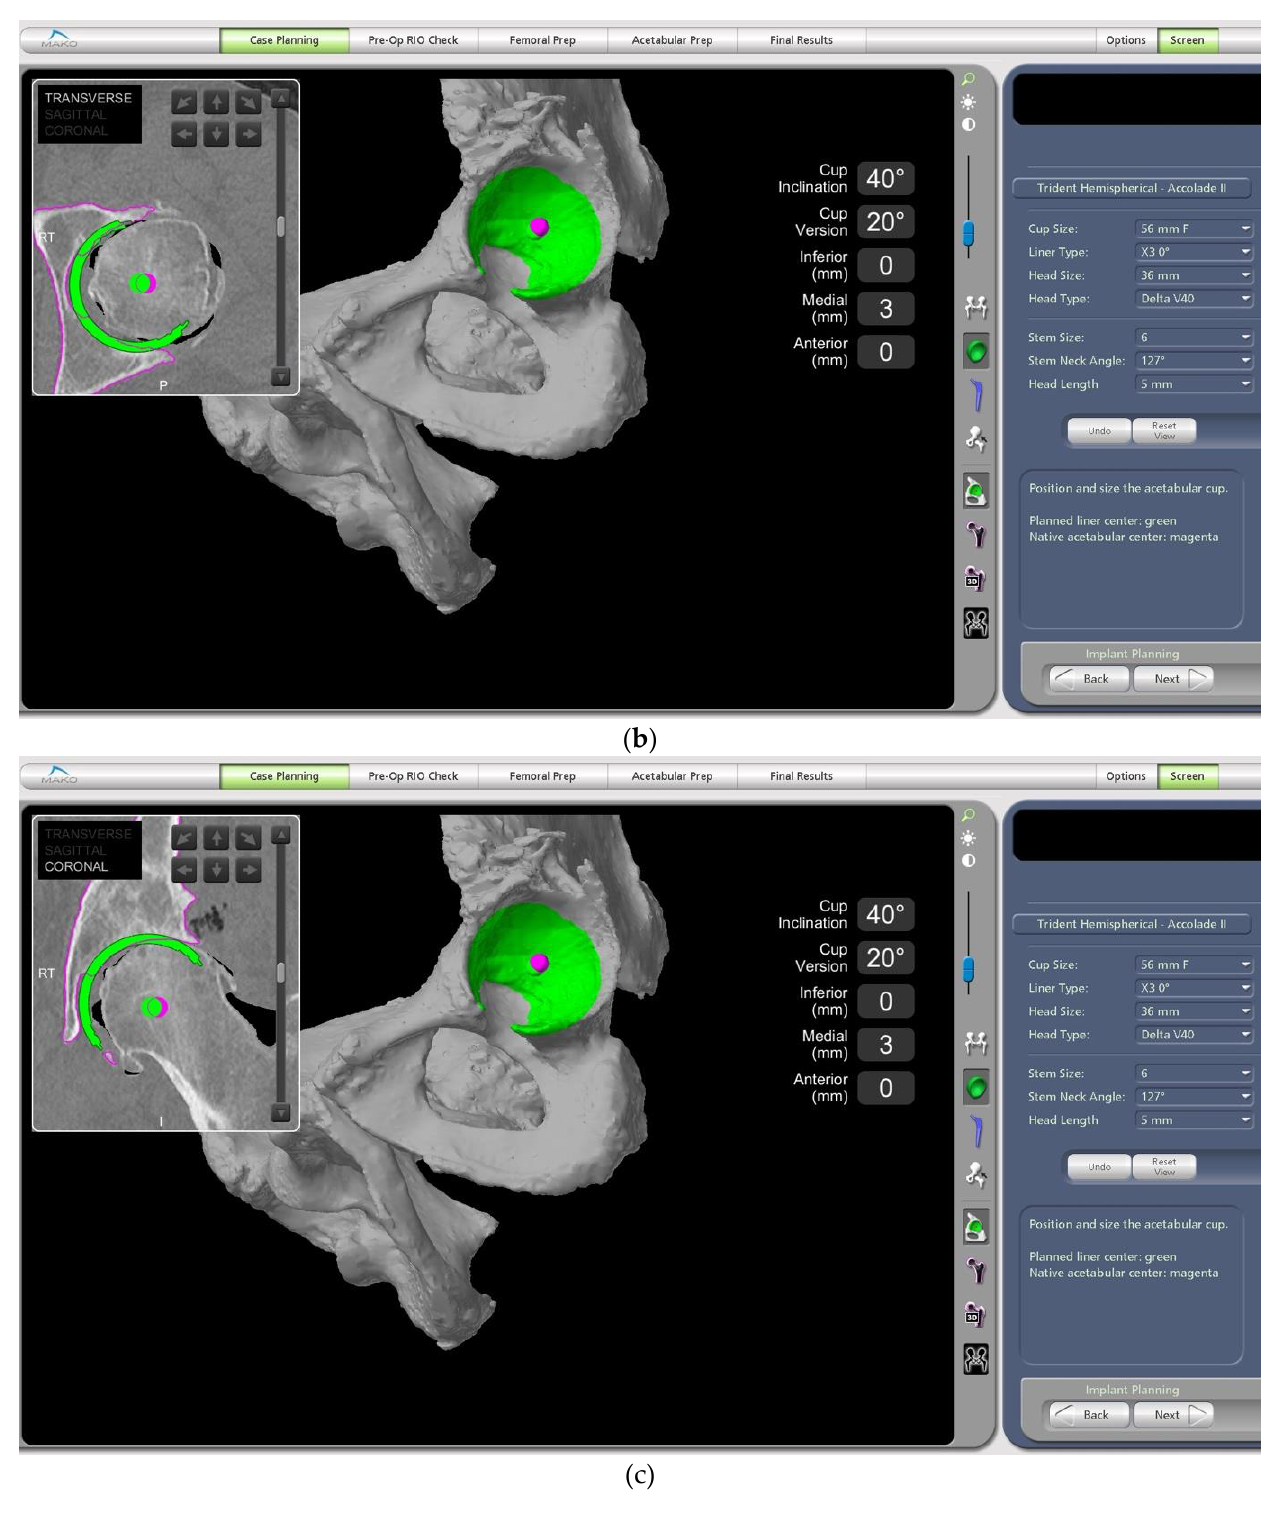
Figure 3. Evaluation of 3D bony coverage of the acetabular cup and careful planning in relation to restoring the native centre of rotation. ( a ) Sagittal. ( b ) Transverse. ( c ) Coronal.